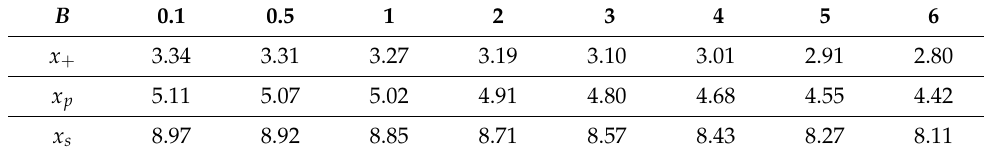
Table 1. The event horizon, photon sphere and shadow dimensionless radii for A = 7, C =